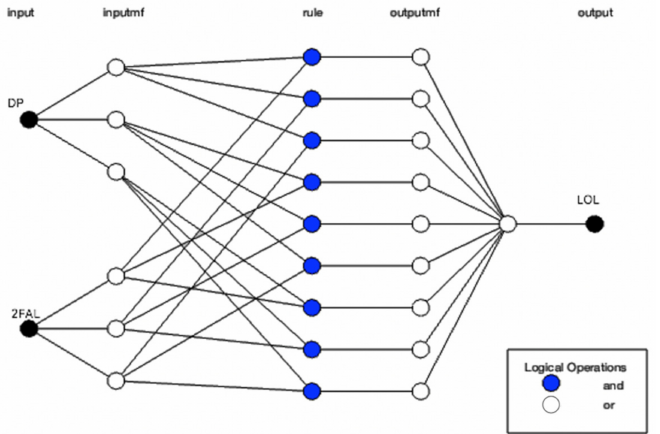
Figure 5. ANFIS architecture: LOL vs. DP.